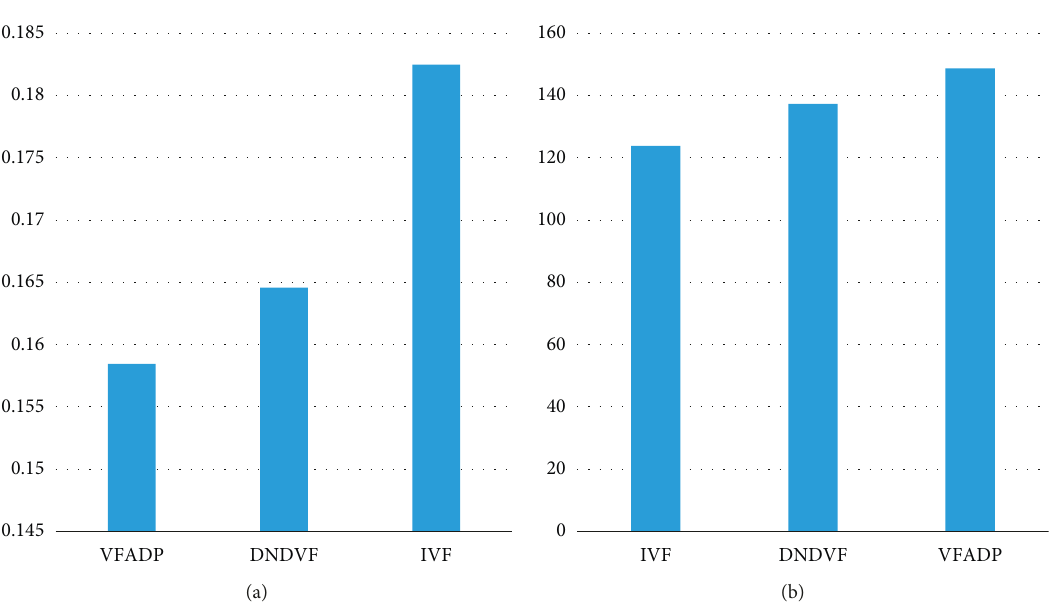
Figure 3: Coverage effect and moving distance in different algorithms when N � 20. (a) Coverage effect. (b) Moving distance